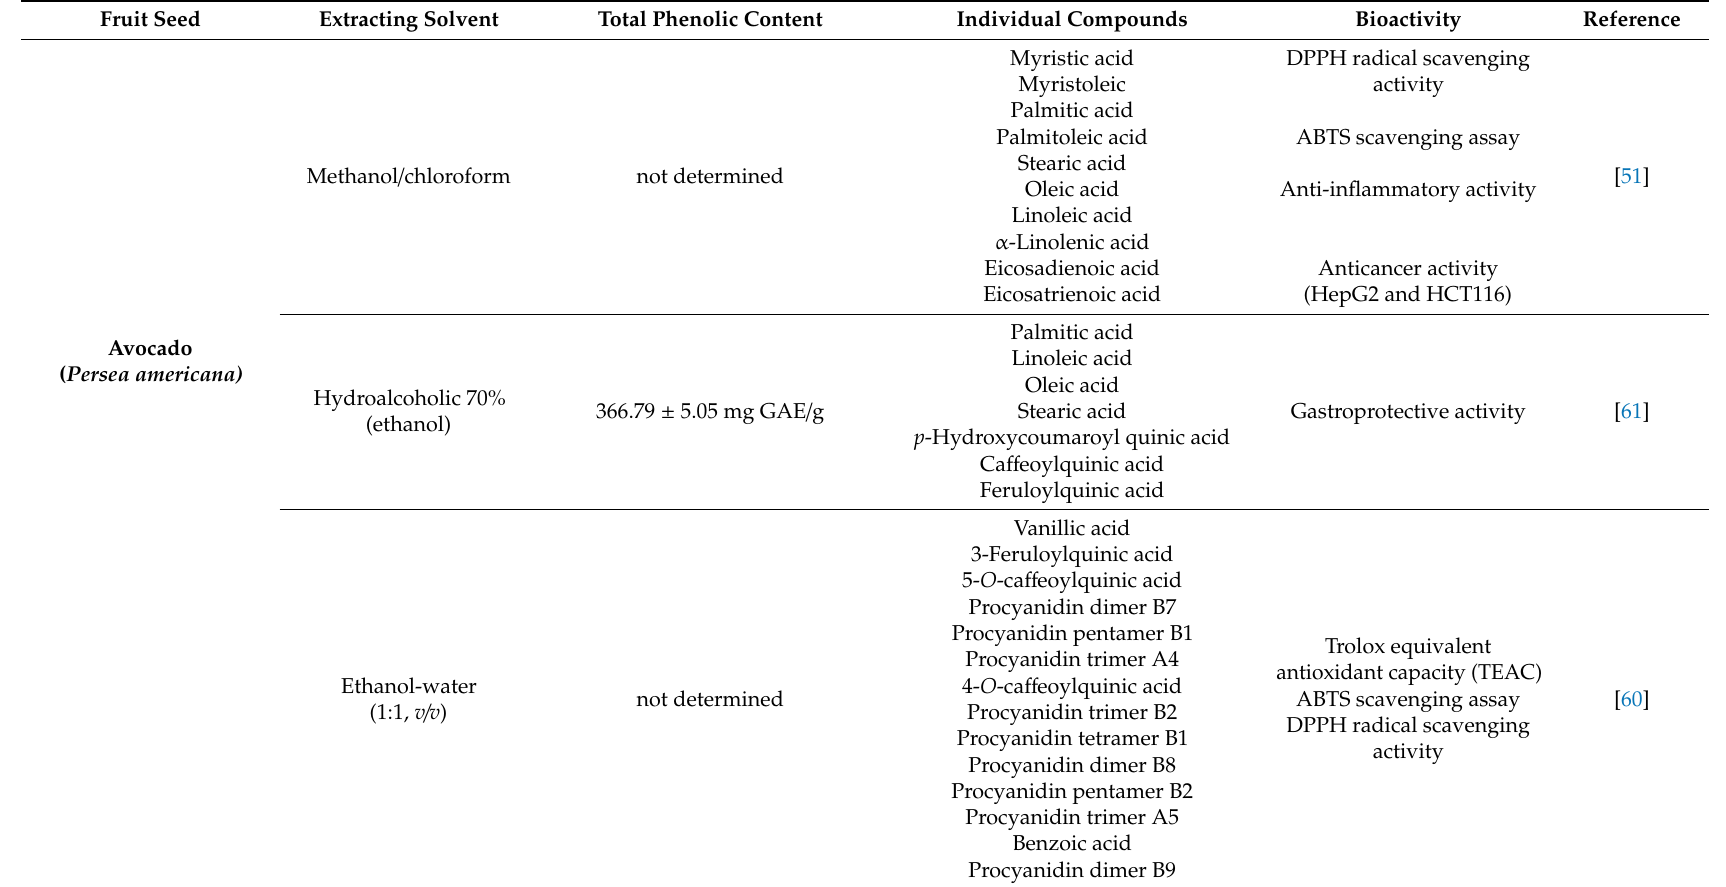
Table 1. Chemical compounds and bioactivity of di ff erent fruit